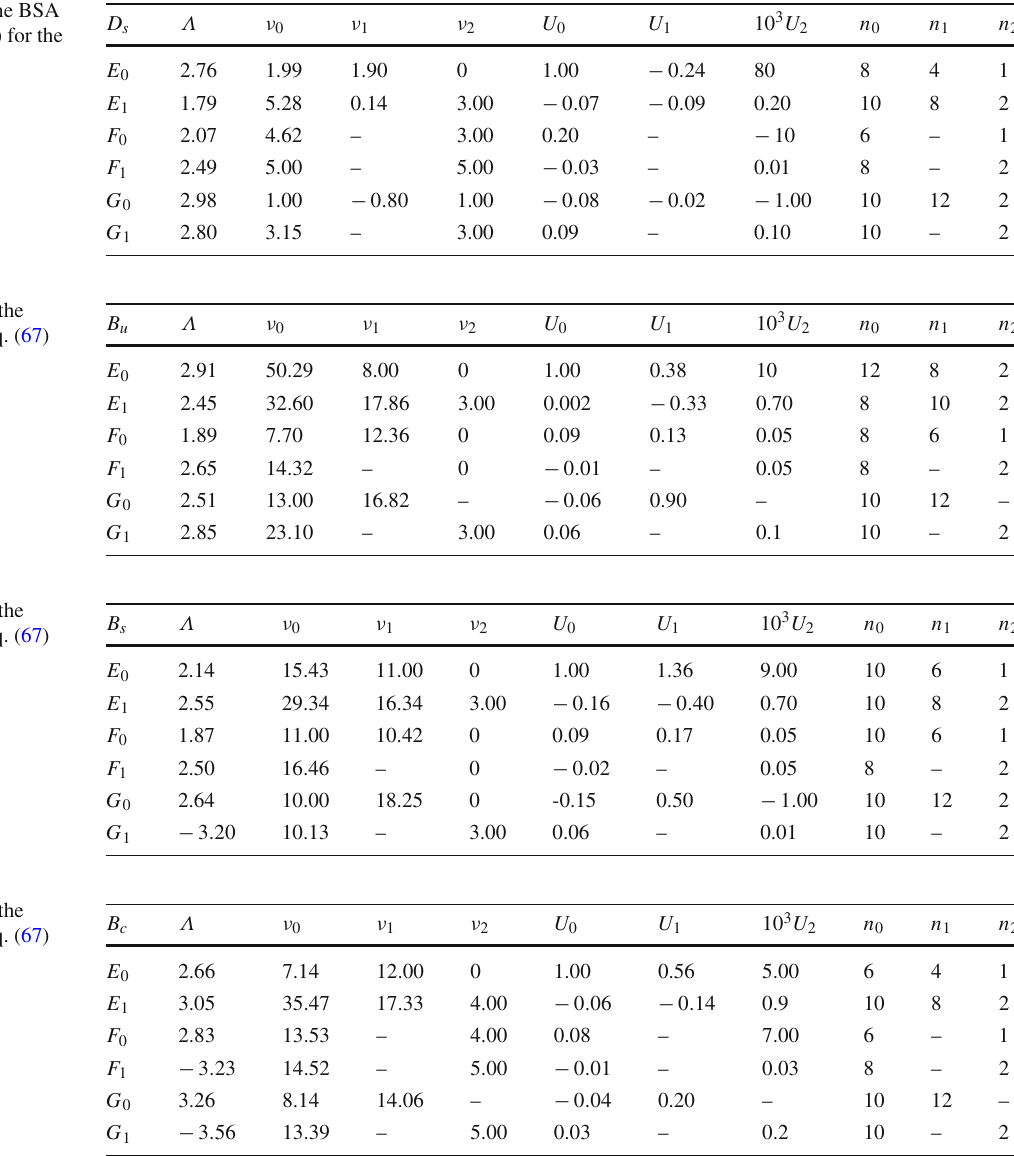
Table 12 Parameters of the BSA representation in Eq. (67) for the B